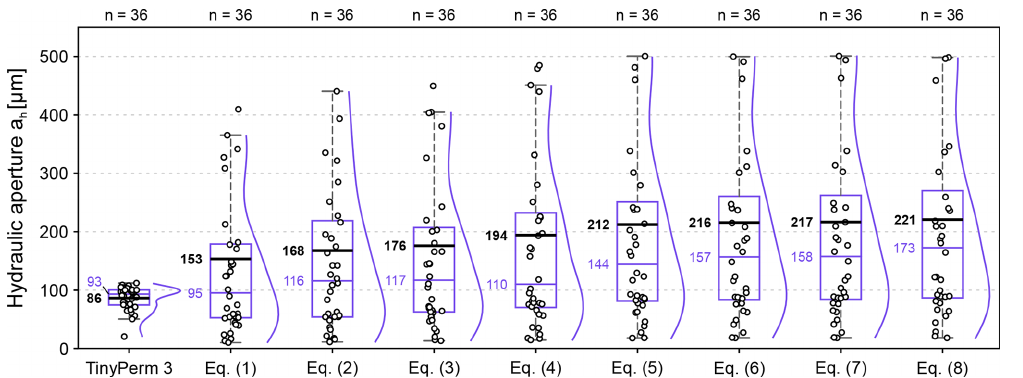
Figure 5. Comparison of hydraulic fracture apertures measured by the air permeameter (TinyPerm 3) and estimated based on mean mechan- ical fracture apertures and standard deviations from microscopic fracture trace analysis. For each dataset, the arithmetic mean (bold black line), the median (thin purple line) and the probability density function (obtained by kernel density estimation) are shown. Values above 550µm are excluded from the